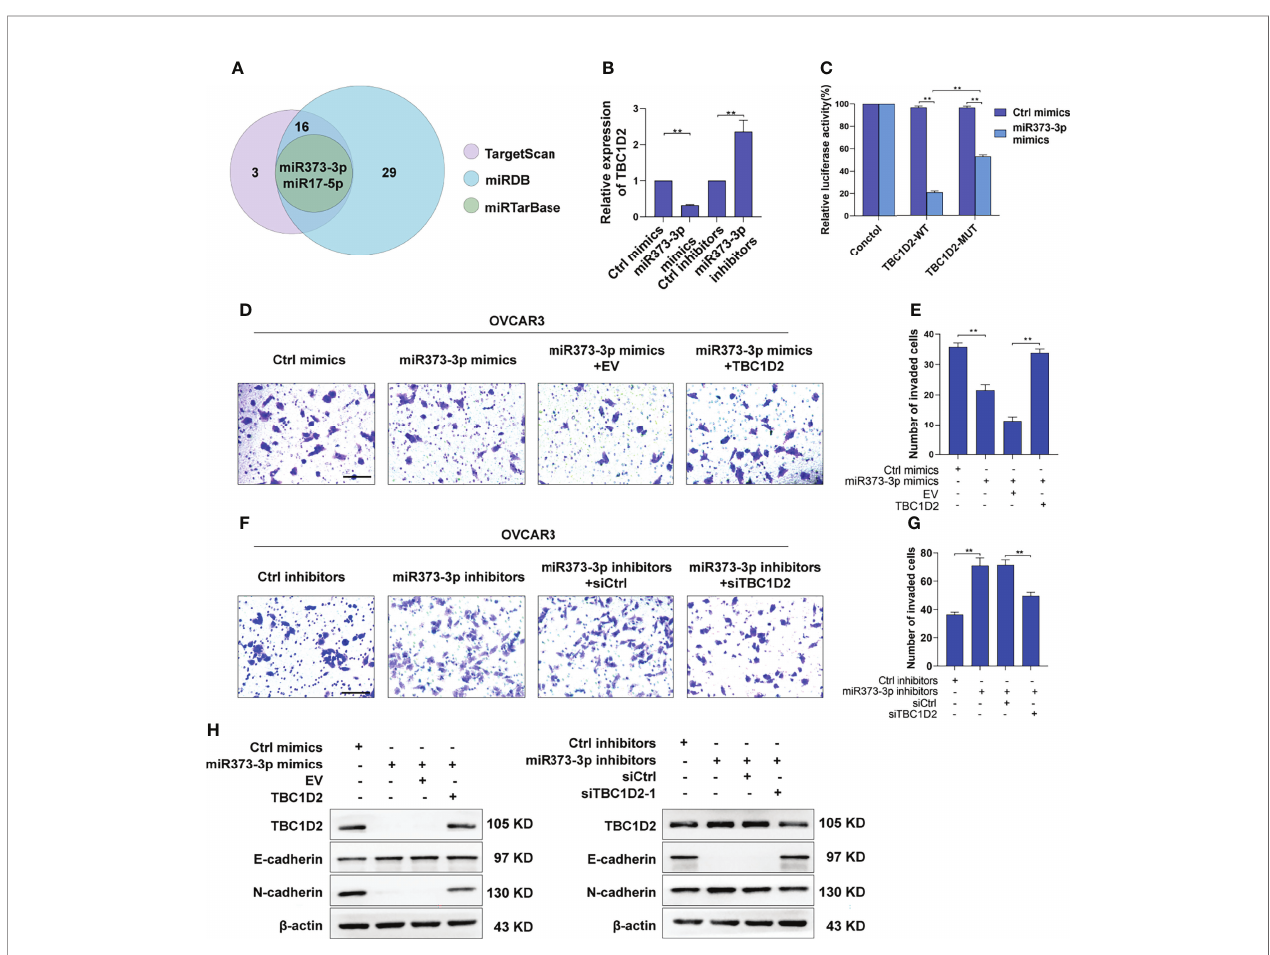
FIGURE 6 | miR-373-3p inhibits invasion of OVCAR3 cells via negative regulation of TBC1D2. (A) Venn diagram of the putative miRNAs targeting TBC1D2 from miRDB, miRTarBase and TargetScan databases. (B) qRT-PCR analysis of TBC1D2 expression in OVCAR3 cells following transfection with miR-373-3p mimics or inhibitors. (C) The regulatory capacity of miR-373-3p on TBC1D2 was assessed by luciferase reporter assay in OVCAR3 cells treated as indicated. WT, wild type; MUT, mutation. (D-G) Representative images and analysis of transwell invasion assay in OVCAR3 cells treated as indicated. EV, empty vector; TBC1D2, overexpression vector encoding TBC1D2; siCtrl, control siRNA; siTBC1D2-1, siRNA against TBC1D2. Scale bars, 100 m m (H) Western blotting images of TBC1D2, E-cadherin, N-cadherin and b -actin in OVCAR3 cells treated as indicated. Two-tailed Student ’ s t tests were used to determine the signi fi cance of differences between two groups; data are represented as mean ± SEM.